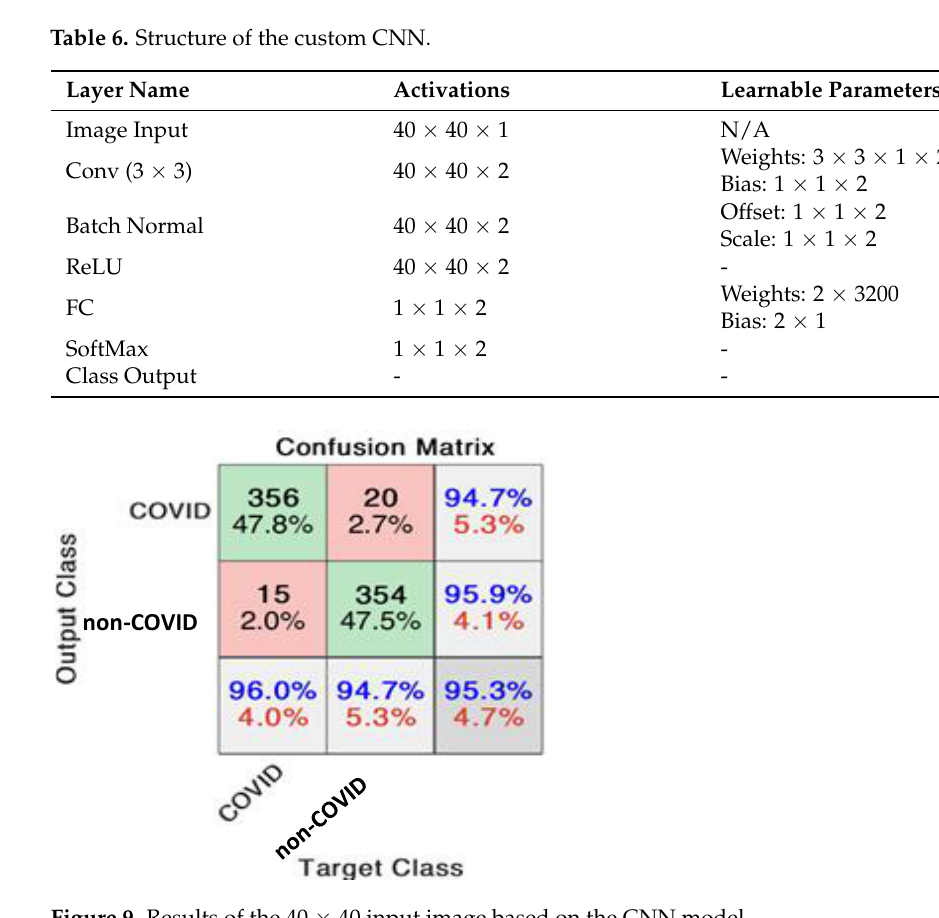
Figure 9. Results of the 40 × 40 input image based on the CNN model.